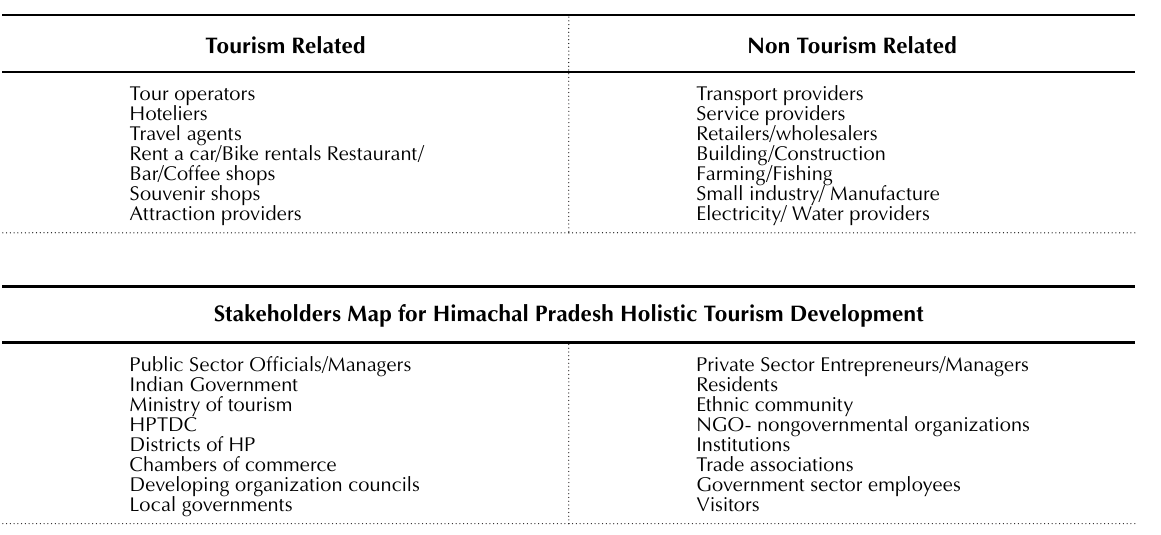
Figure 1. Stakeholder map for studying heritage tourism in Himachal